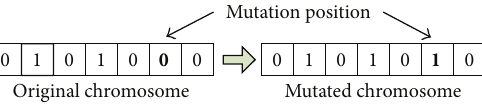
Figure 11: Mutation operation